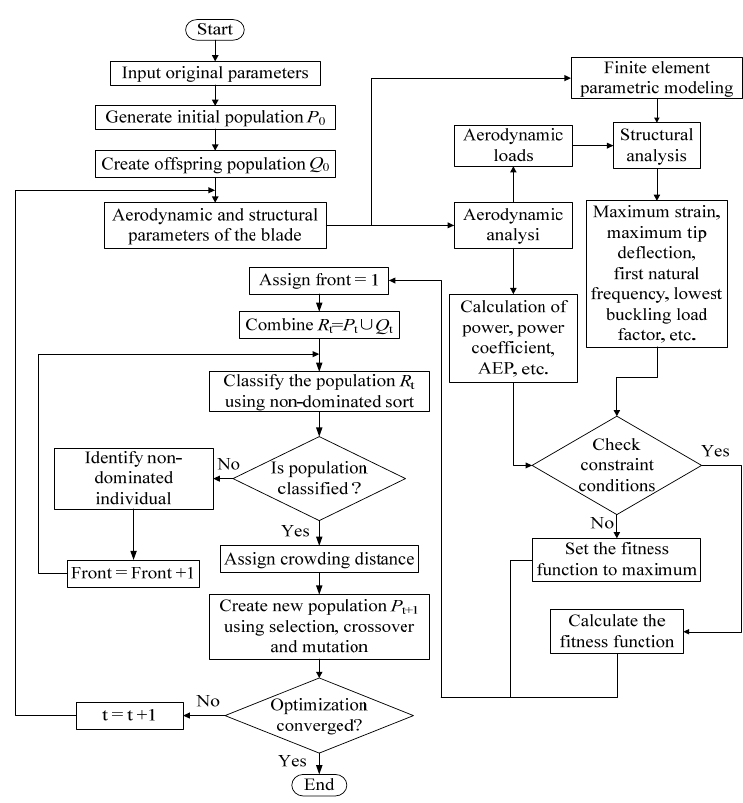
Figure 11. Flowchart of the integrated optimization process.